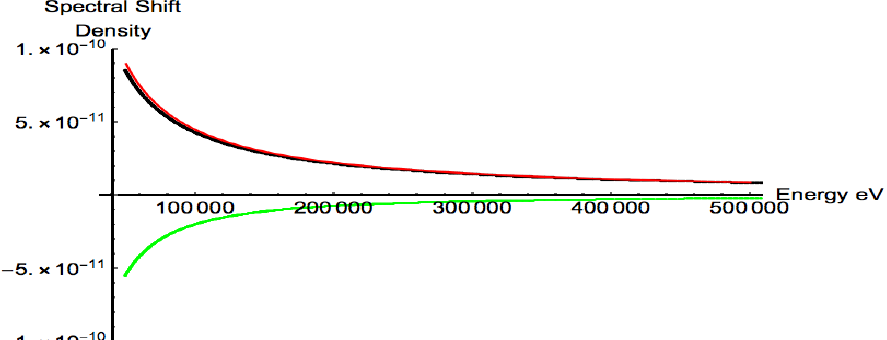
Figure 9. Top red curve is the 1S group theoretical calculated spectral density (29), slightly lower black curve is the 1/ E asymptotic model Equation (39), and the bottom green curve is the difference times 10, plotted for the interval 50–510 keV. Both axes are